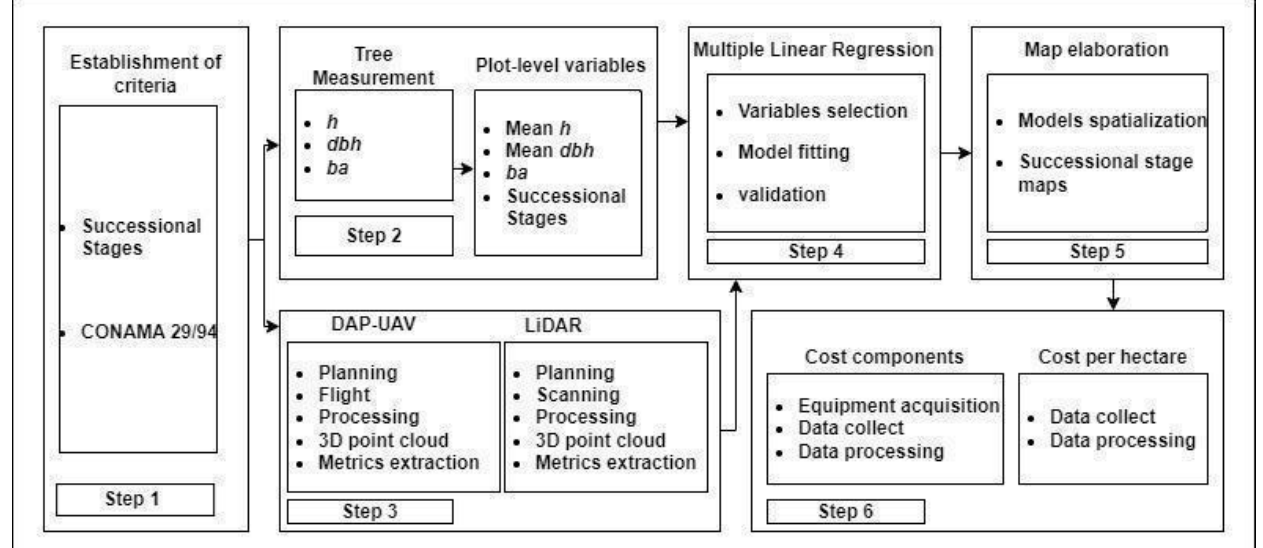
Figure 2. Flow of structured steps to perform the work.